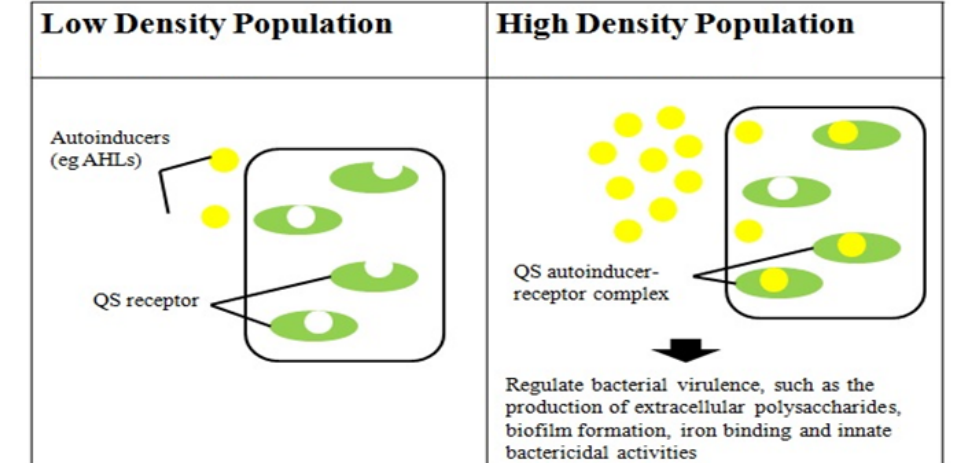
Figure 2. Diagram of quorum